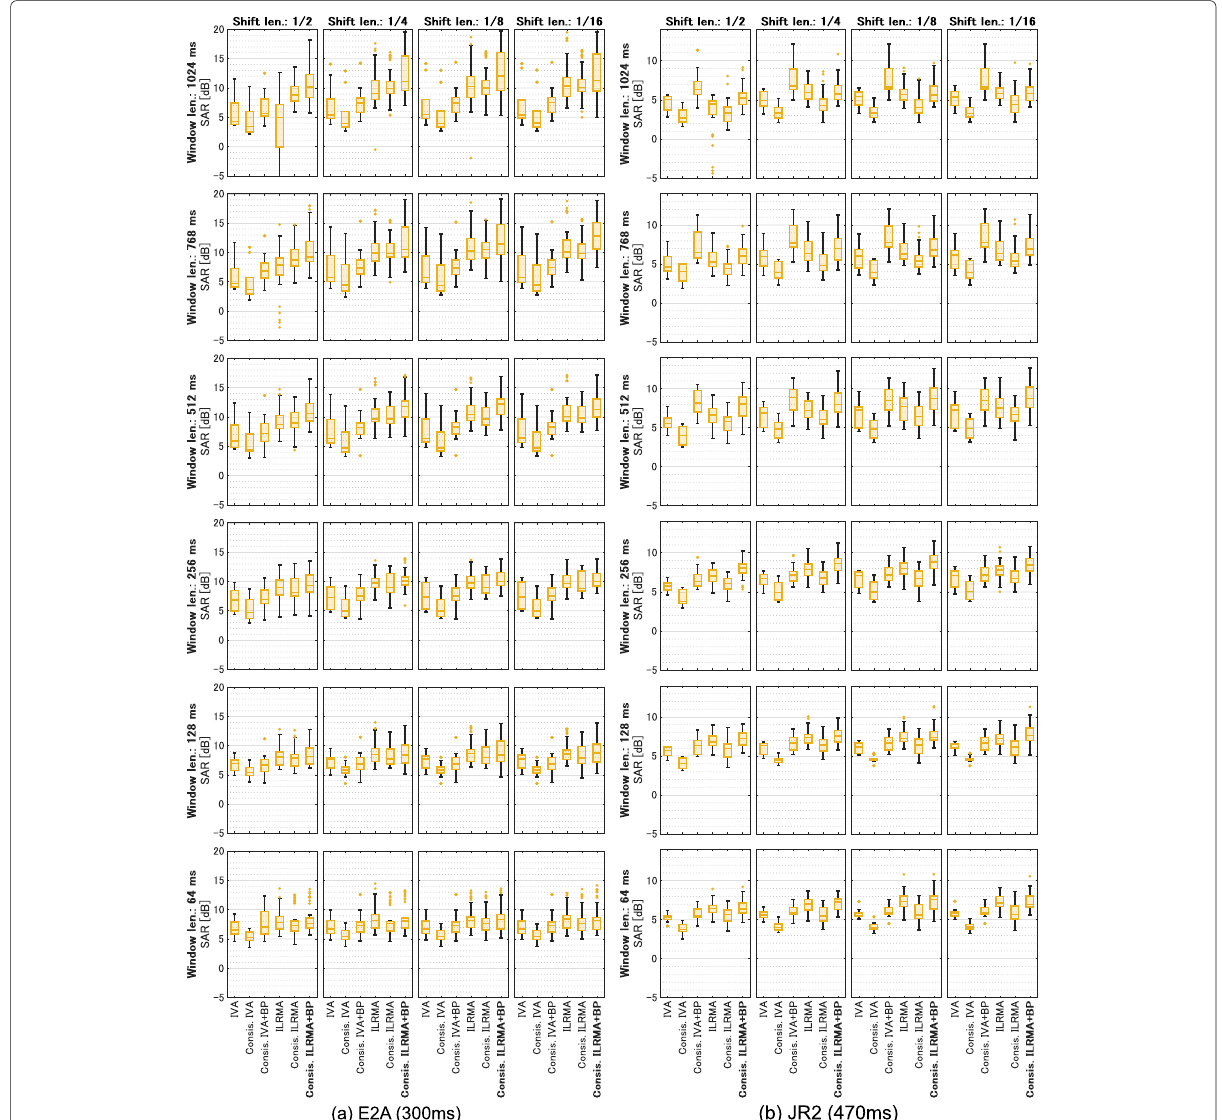
Fig. 26 Average SAR for synthesized speech mixtures (speech 1–10) with a E2A and b JR2 , where Hamming window is used in